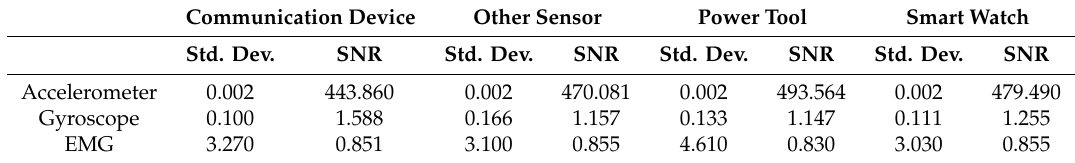
Table 4. E ff ect of confounding factors on data quality for at-rest activity. Table 4. Effect of confounding factors on data quality for at-rest activity.